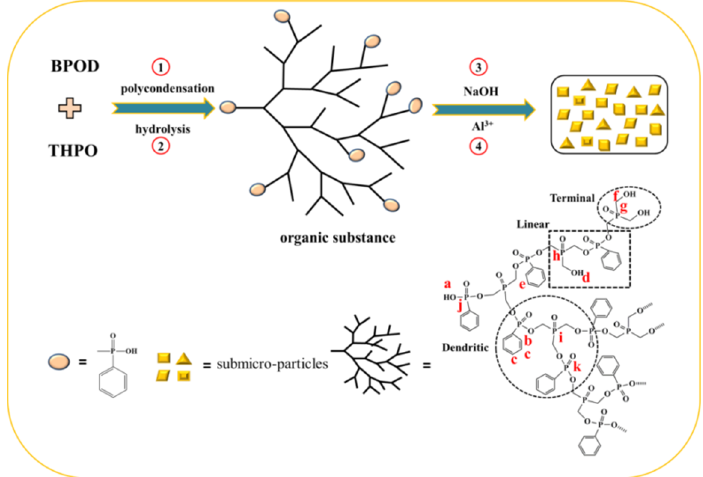
Figure 1. Synthetic route of hyper-branched aluminum phosphonate (AHPP) via the dehydrochlorination of tris(hydroxymethyl)phosphine oxide (THPO) with benzene phosphorus oxydichloride (BPOD).